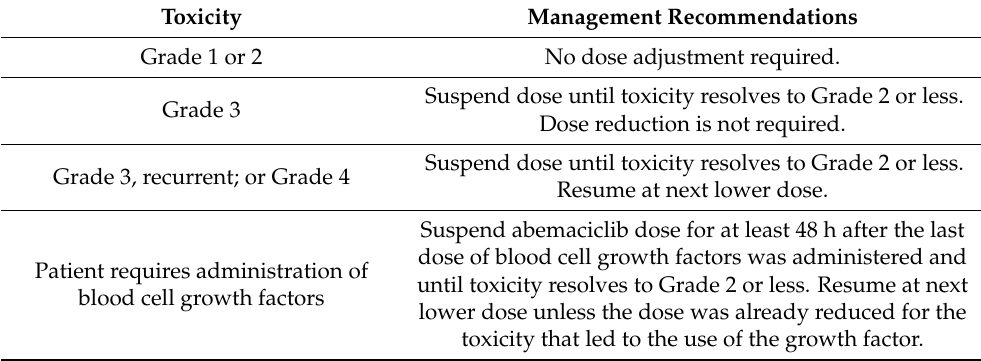
Table 4. Dose modifications and management of neutropenia caused by abemaciclib, according to abemaciclib US prescribing information, accessed in March